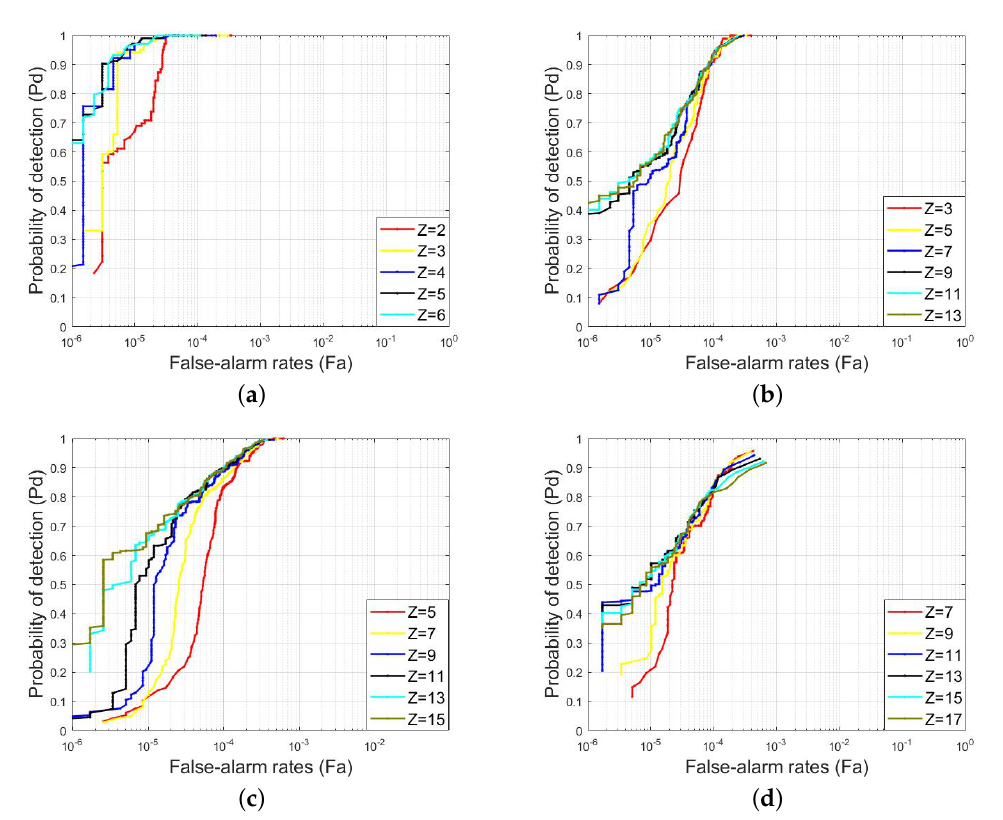
Figure 9. The ROC curves for different Z values in four windows: sliding window of ( a ) 3 × 3; ( b ) 5 × 5; ( c ) 7 × 7; and ( d ) 9 ×